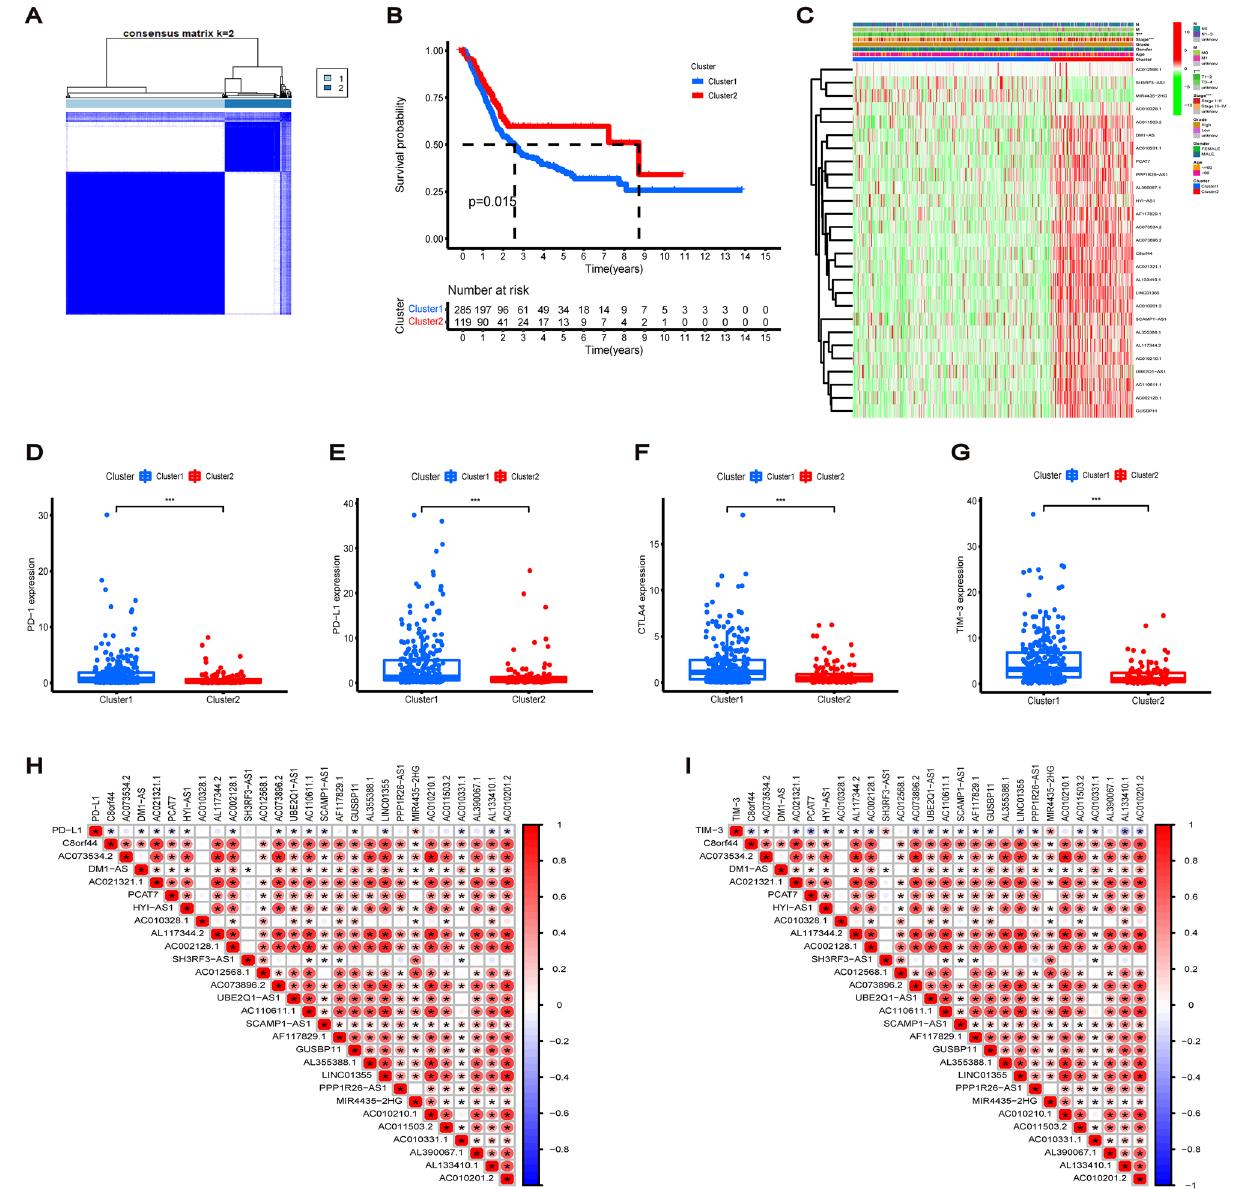
( C ) Heatmap and the clinicopathological features of two clusters, including gender, age, T, M, N status and pathological grade. ( D – G ) Differential expression of immune checkpoint genes (PD-1, PD-L1, CTLA-4 and TIM-3) in the two clusters. ( H , I ) The correlation of immune checkpoint genes (PD-L1 and TIM-3) with 27 cuproptosis-related lncRNAs linked to survival. * P < 0.05, ** P < 0.01, and *** P <